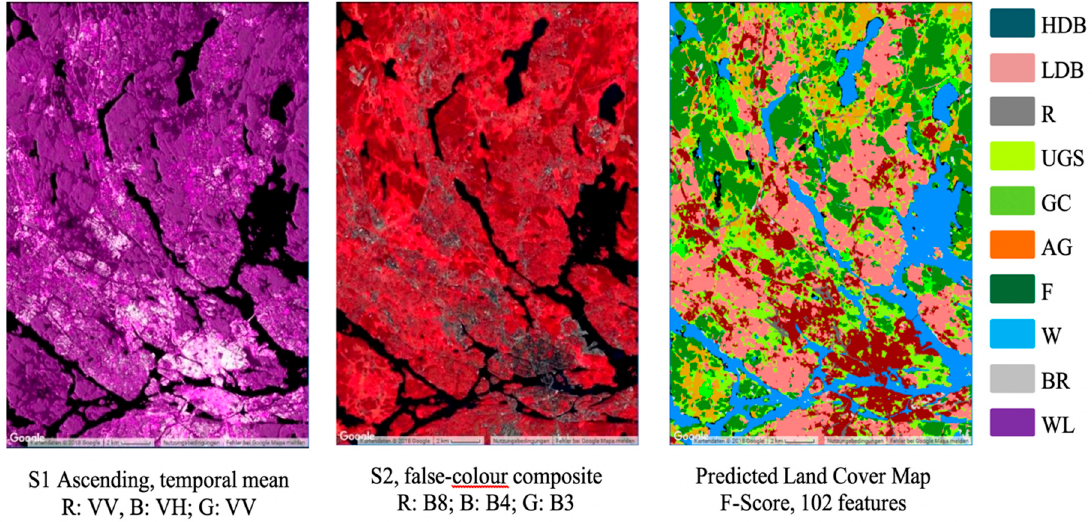
Figure 10. Display of input images and a resulting land cover map.